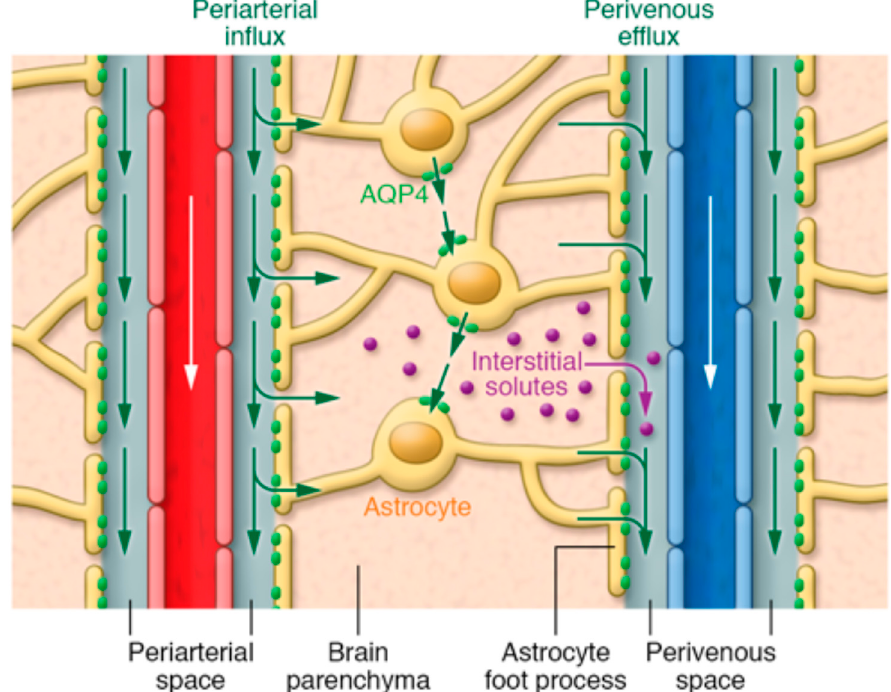
Figure 1. Illustration of fluid and interstitial waste solutes movement in the brain between the parenchyma and perivascular spaces surrounding the penetrating vasculature. The periarterial influx in the figure shows the inward movement of CSF along the periarterial space, which mixes with the ISF and interstitial waste solutes in the parenchyma with the help of AQP-4 and gaps between astrocytic end-feet, and then exit via perivenous efflux pathway (along the perivenous space). White arrows indicate the direction of blood flow in the vasculature. Green arrows show the CSF and CSF- ISF fluid transport (whether by diffusion, bulk flow, or both remains elusive). Purple dots indicate the interstitial waste solutes that exit the parenchyma through gaps between the astrocytic end-feet into the perivenous space, which are then drained to the CSF. Reproduced with permission from [15] .